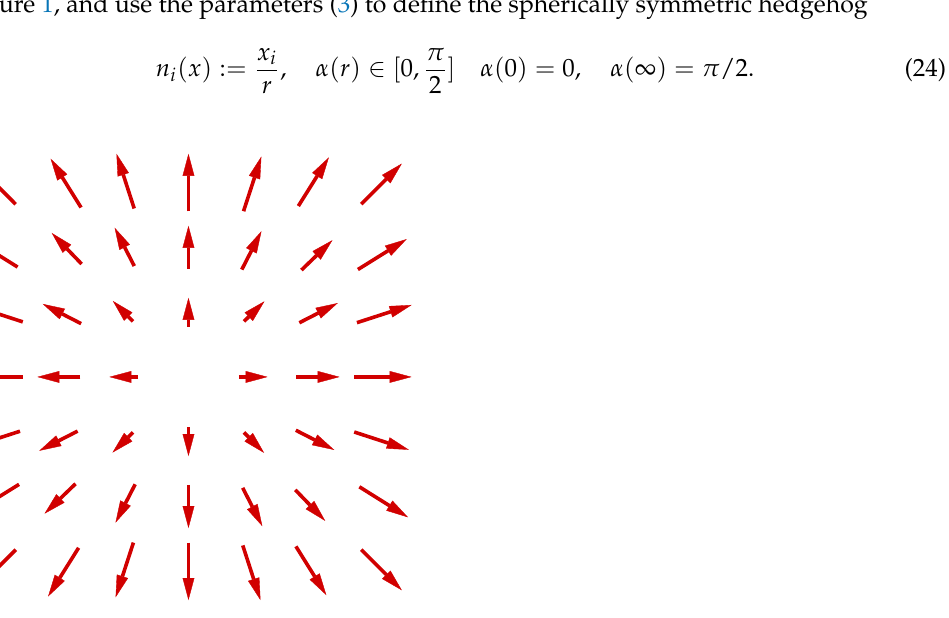
Figure 1. Depicted is the imaginary part (cid:126) q ( x ) = (cid:126) n ( x ) sin α ( x ) of the soliton field Q ( x ) of Equation (1) in a symmetry